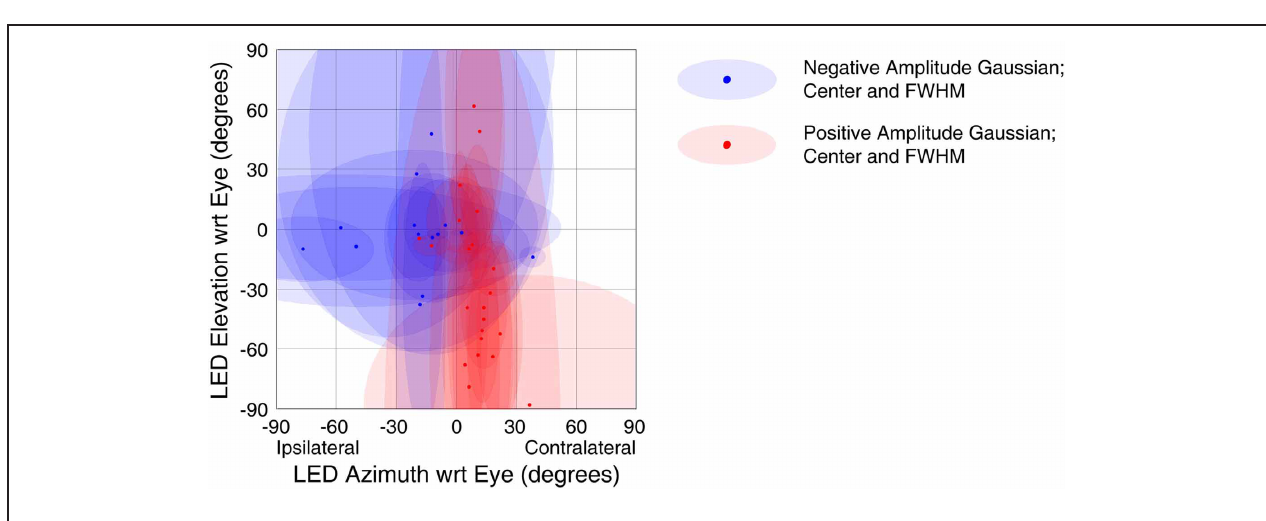
FIGURE 9 | Spatial tuning of visual responses. Receptive fields across all visually sensitive sites were summarized using a Gaussian fitting procedure (see Materials and Methods). The centers of the Gaussian functions are shown with red (Gaussian peaks) and blue (Gaussian troughs) points, and